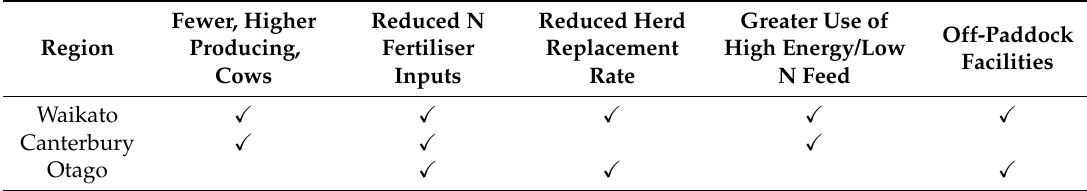
Table 1. ‘Improved’ system changes applied to farmlet system trials in Waikato, Canterbury, and Otago, New